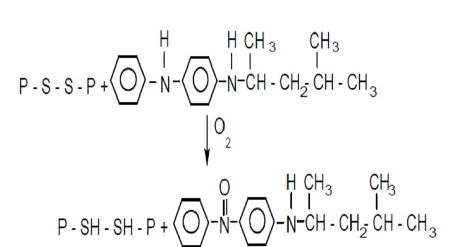
Figure 16. Redox mechanism between stabilizer and elastomer 30 .